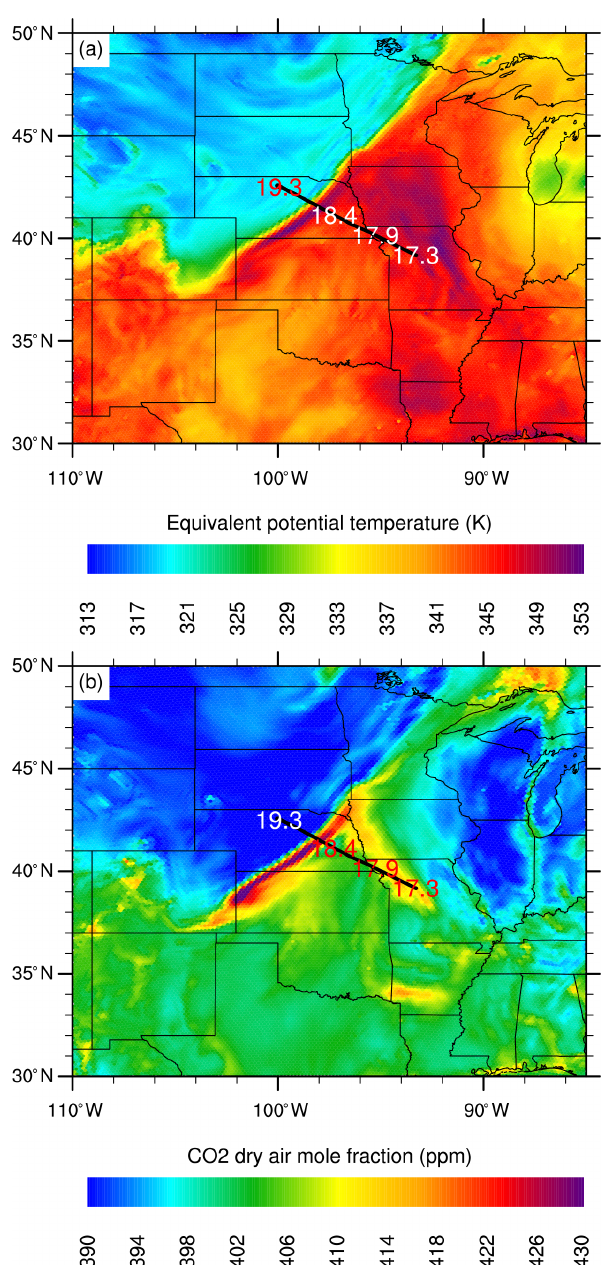
Figure 13. MPAS-A simulated equivalent potential temperature ( θ e , a ) and CO 2 mole fraction (b) at 18:00UTC on 4 August 2016. Both figures are plotted at the sixth MPAS-A vertical level, which is about 400m above the ground.